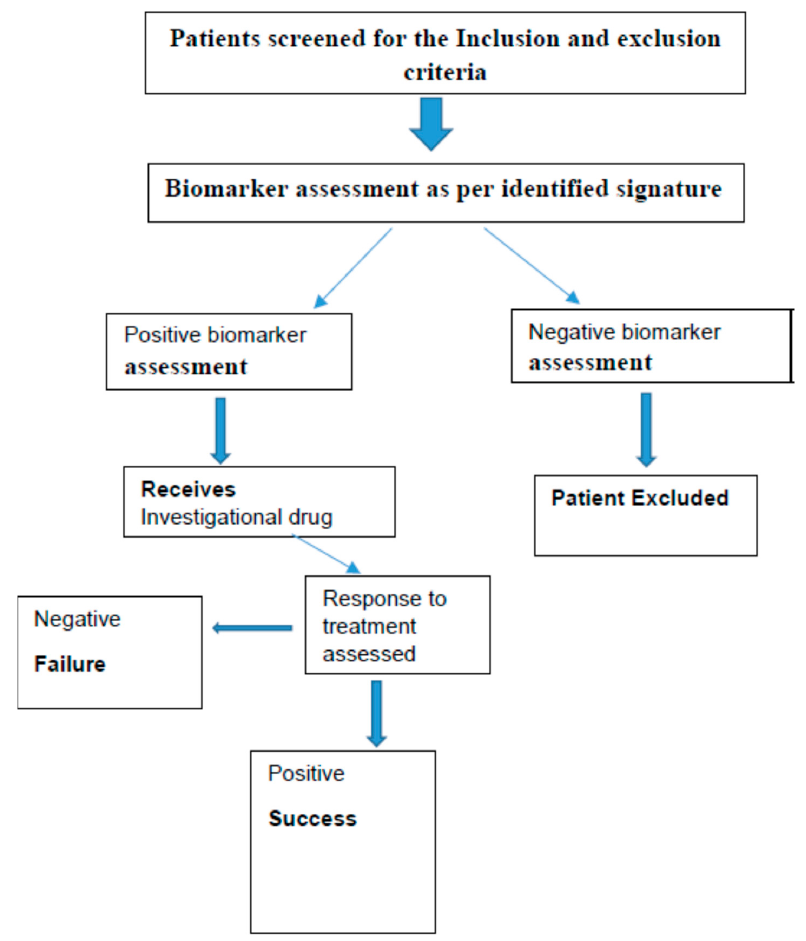
Figure 5. Single arm, open label—one stage biomarker enriched design approach.